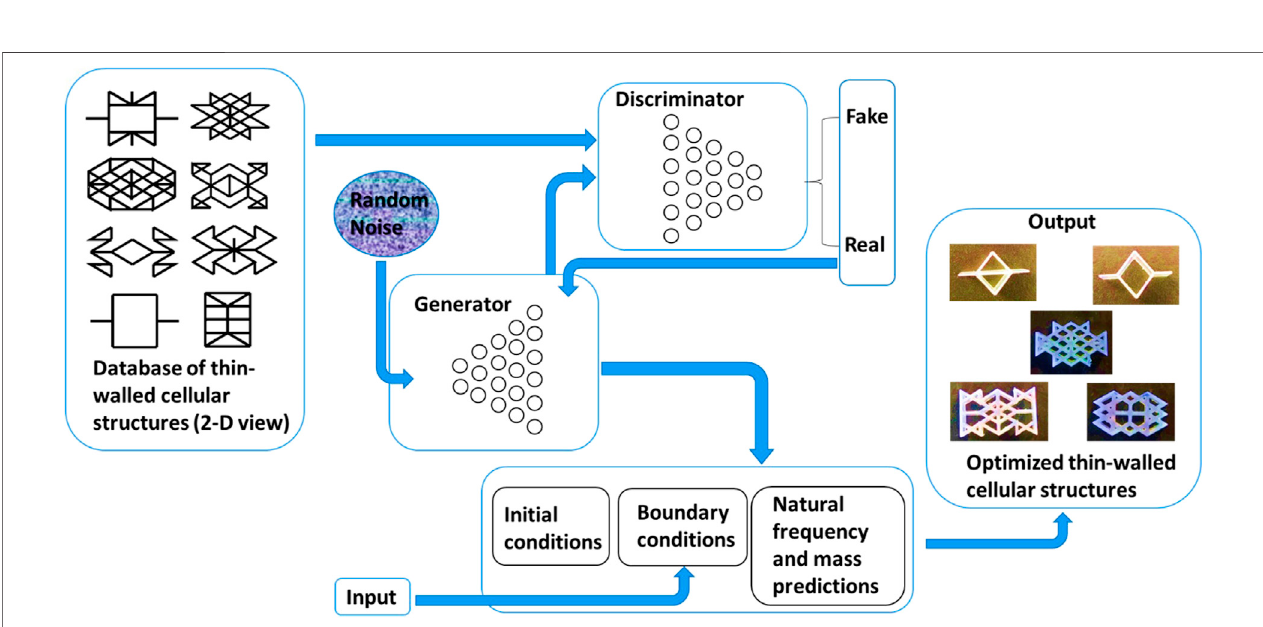
FIGURE 3 | Framework for inverse design of optimal cellular unit cells. Step 1. The GAN system is trained to generate novel cellular unit cell fi ngerprints. Step 2. Desired properties (high natural frequency, low mass) are fed as inputs to the boundary conditions. Step 3. The newly generated fi ngerprints from the GAN system are passed through the boundary conditions and forward regression model for mass and natural frequency predictions. Step 4. Optimal cellular unit cell fi ngerprints that satisfy the boundary conditions are produced.